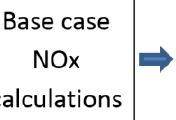
Figure 2. Block diagram of the determination of the required SNCR NOx reduction.